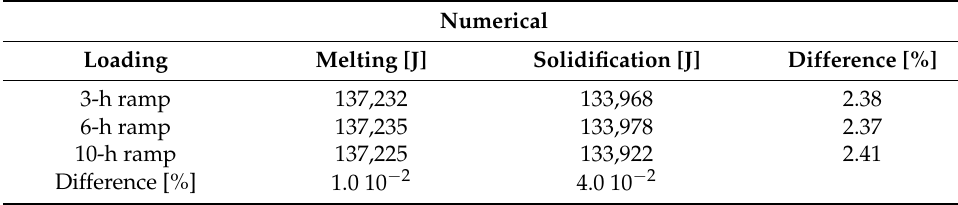
Table 7. Energy balance, from the numerical heat